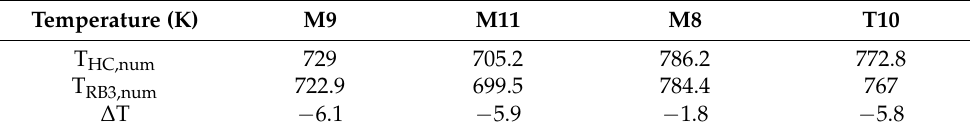
Table 10. Test 4: Numerical temperature of honeycomb and rhomboidal cells. Temperature (K)